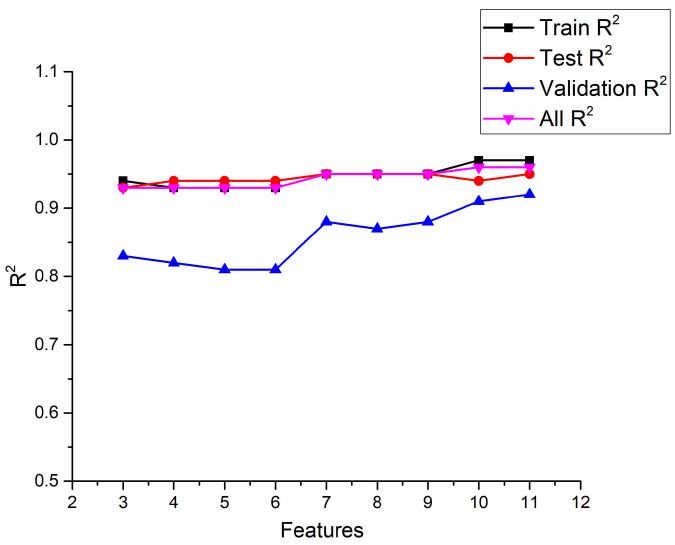
Figure 6. Performance R 2 statistics results of the H 2